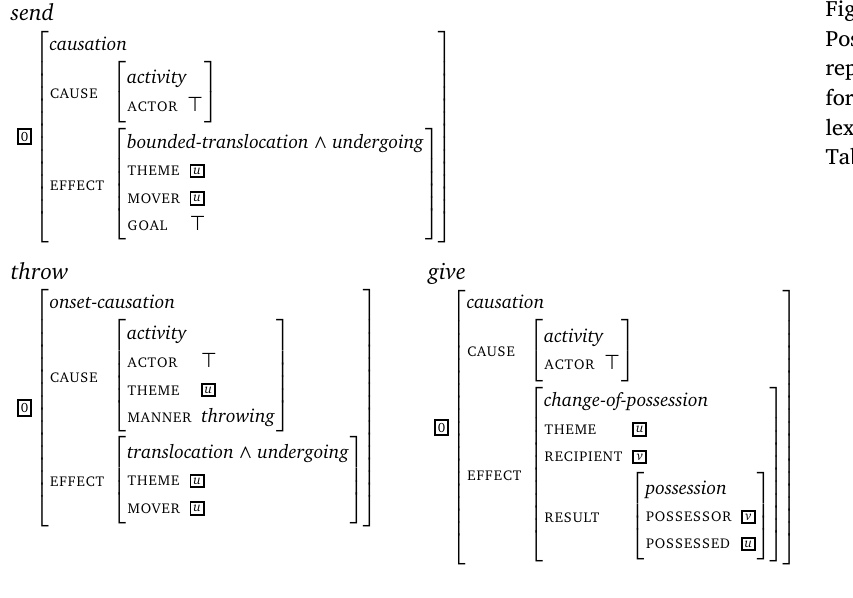
Possible frame representations for some of the lexical items